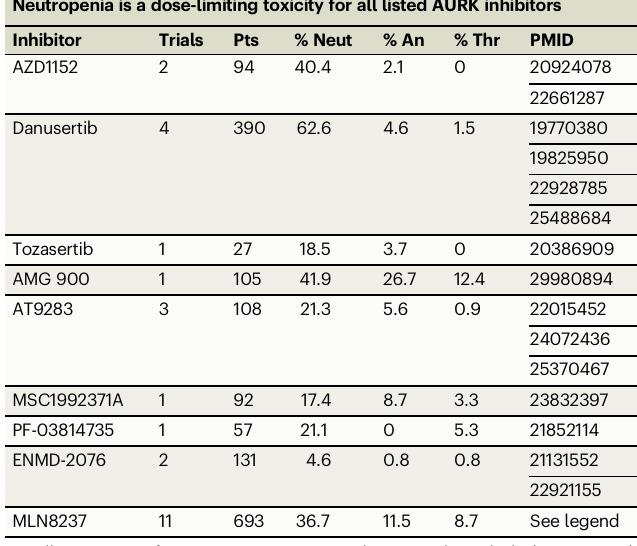
Table 1 | Patients treated with existing Aurora kinase inhibitors experience neutropenia-biased hematotoxicity Neutropenia is a dose-limiting toxicity for all listed AURK inhibitors